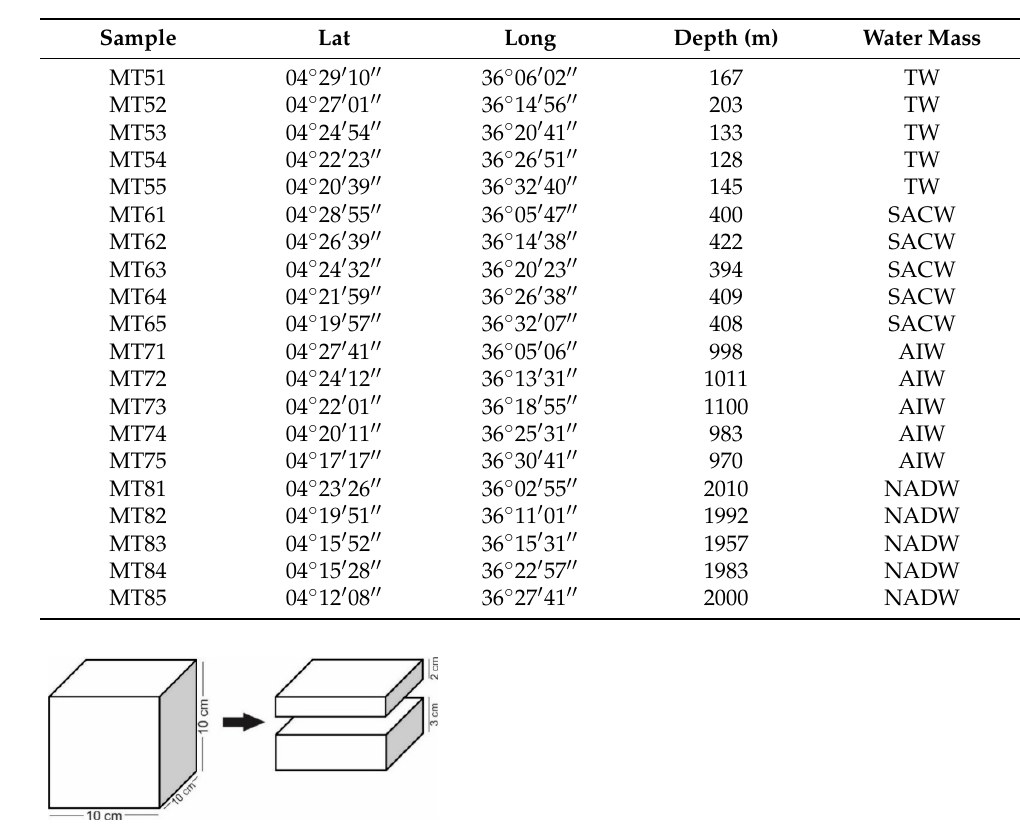
Figure 2. Schematic diagram of sampling sectioning (surface 0–2 cm and subsurface 2–5 cm) layers.